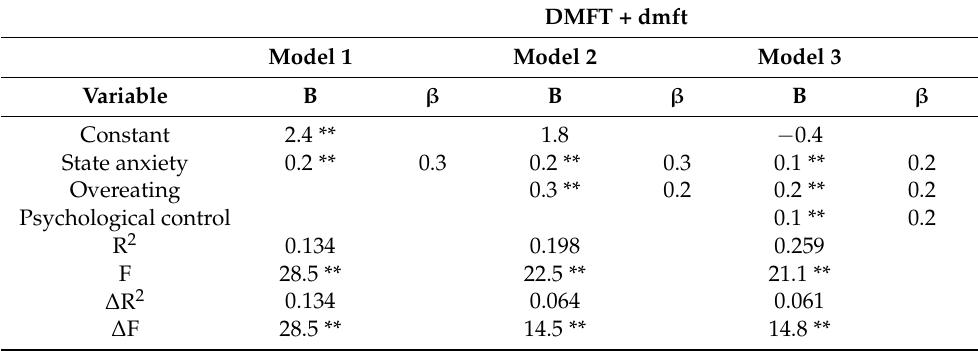
Table 3. Results of regression analysis to predict DMFT + dmft from state anxiety, overeating, and parental psychological